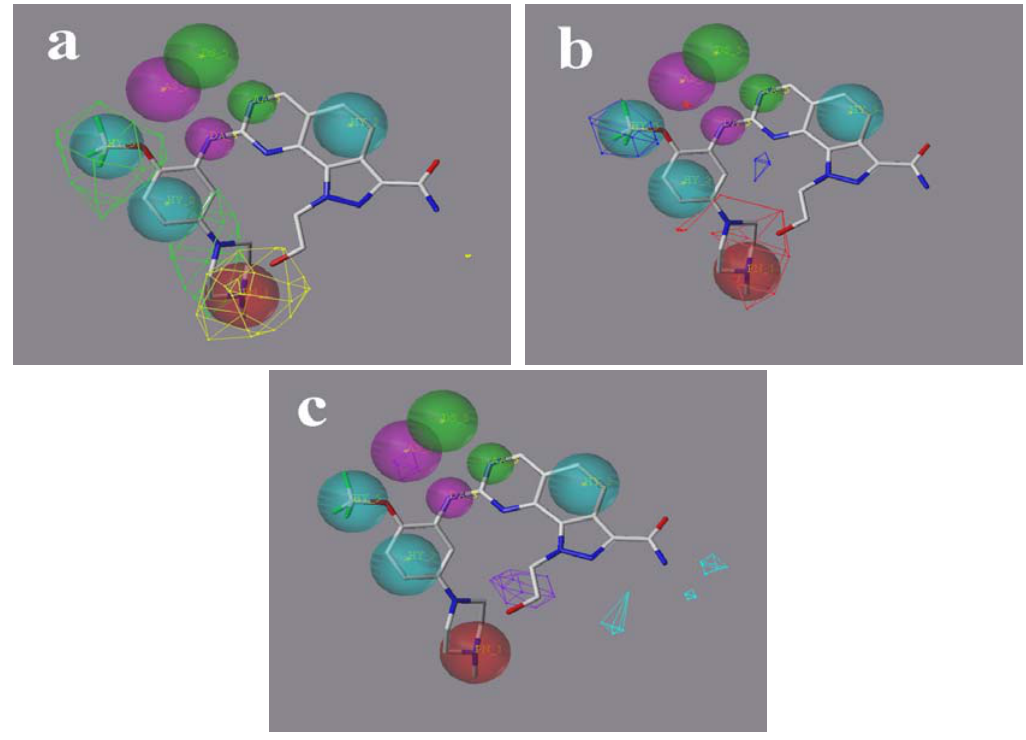
Figure 8. The pharmacophore model superimposed with ( a ) steric; ( b ) electrostatic and ( c ) hydrogen bond donor and acceptor contours of model 6. The pharmacophore features are colored the same as in Figure 4. The contours are depicted as